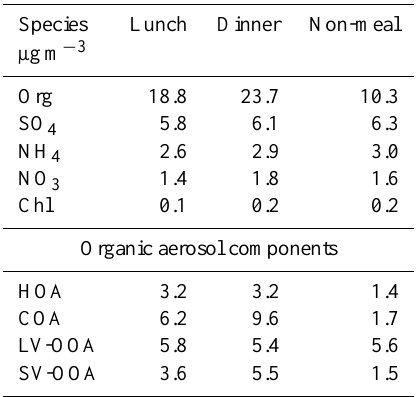
Figure 7. Variation of the average concentration of OA components (HOA, SV-OOA, LV-OOA and COA) coded by color as a function of binned O x concentration (ppb) and binned temperature ( ◦